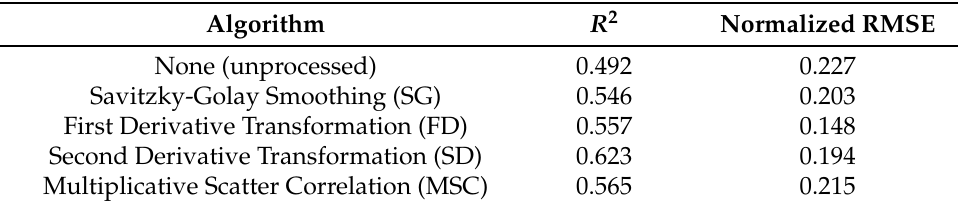
Figure 7. The spectral reflectance curves of the bare-soil arsenic samples after spectral preprocessing through: SG ( top left ), FD ( top right ), SD ( bottom left ), and MSC ( bottom right ). Line colors are used to differentiate samples only. Table 2. Comparison of the R 2 and nRMSE values of the four noise reduction algorithms tested. Refer to the Abbreviations section at the end of the paper for full technique